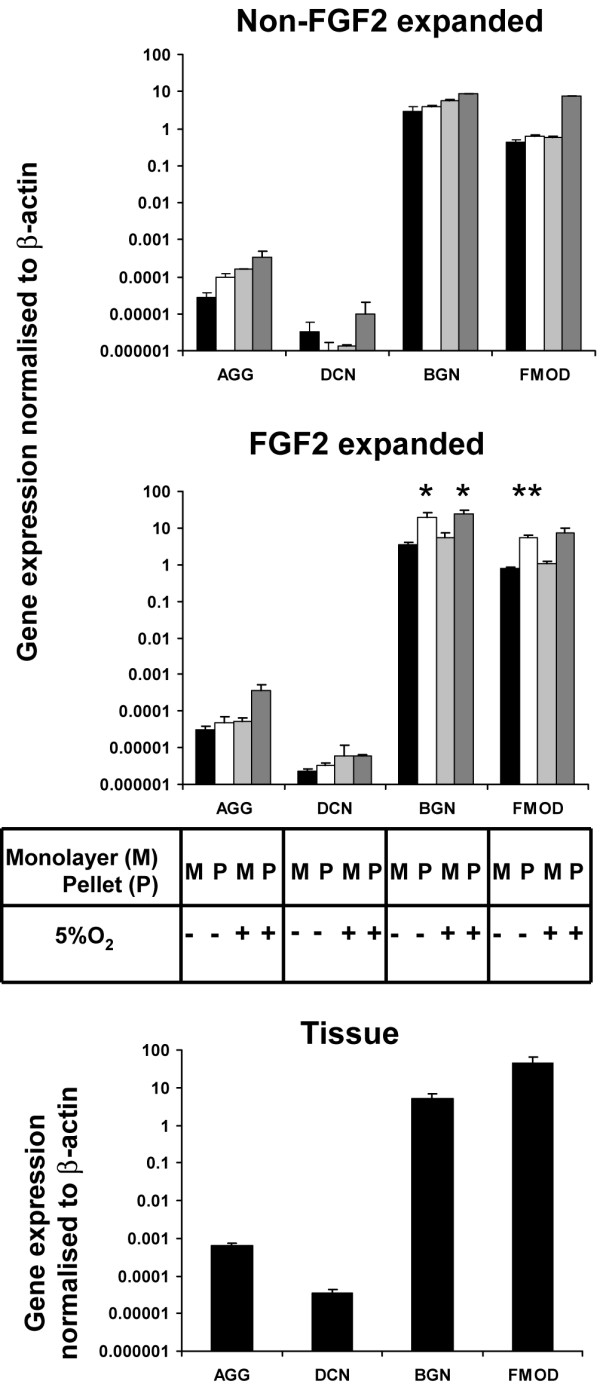
Proteoglycan gene expression in monolayer and aggregate cultures from non-FGF2 and FGF2 expanded meniscus cells. Gene expression levels for monolayer cells (black bars) between P2 and P3 in standard medium (n = 3) and for cell aggregate (white open bars) in chondrogenic differentiation medium (n = 3) under normal oxygen after 14 days in culture. Gene expression for monolayer cells (light grey bars) between P2 and P3 in standard medium (n = 3) and for cell aggregate (dark grey bars) in chondrogenic differentiation medium (n = 3) under hypoxia after 14 days in culture. AGG, aggrecan; BGN, biglycan; DCN, decorin; FGF2, fibroblast growth factor 2; FMOD, fibromodulin; P2, passage 2; P3, passage 3.